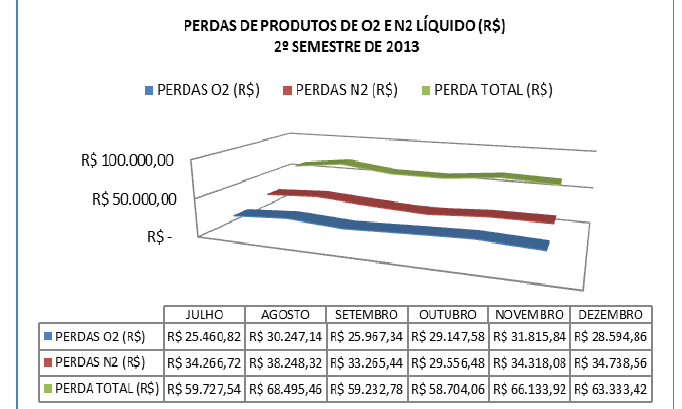
e N líquidos - m³- 2º semestre de 2 2